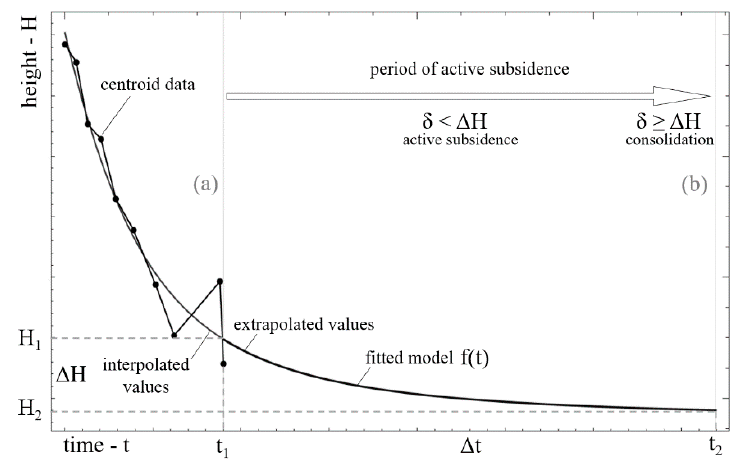
Figure 8. The FNSE model for consolidation prognosis (modified sigmoid function developed and used by Faculty of Natural Sciences and Engineering [34]).